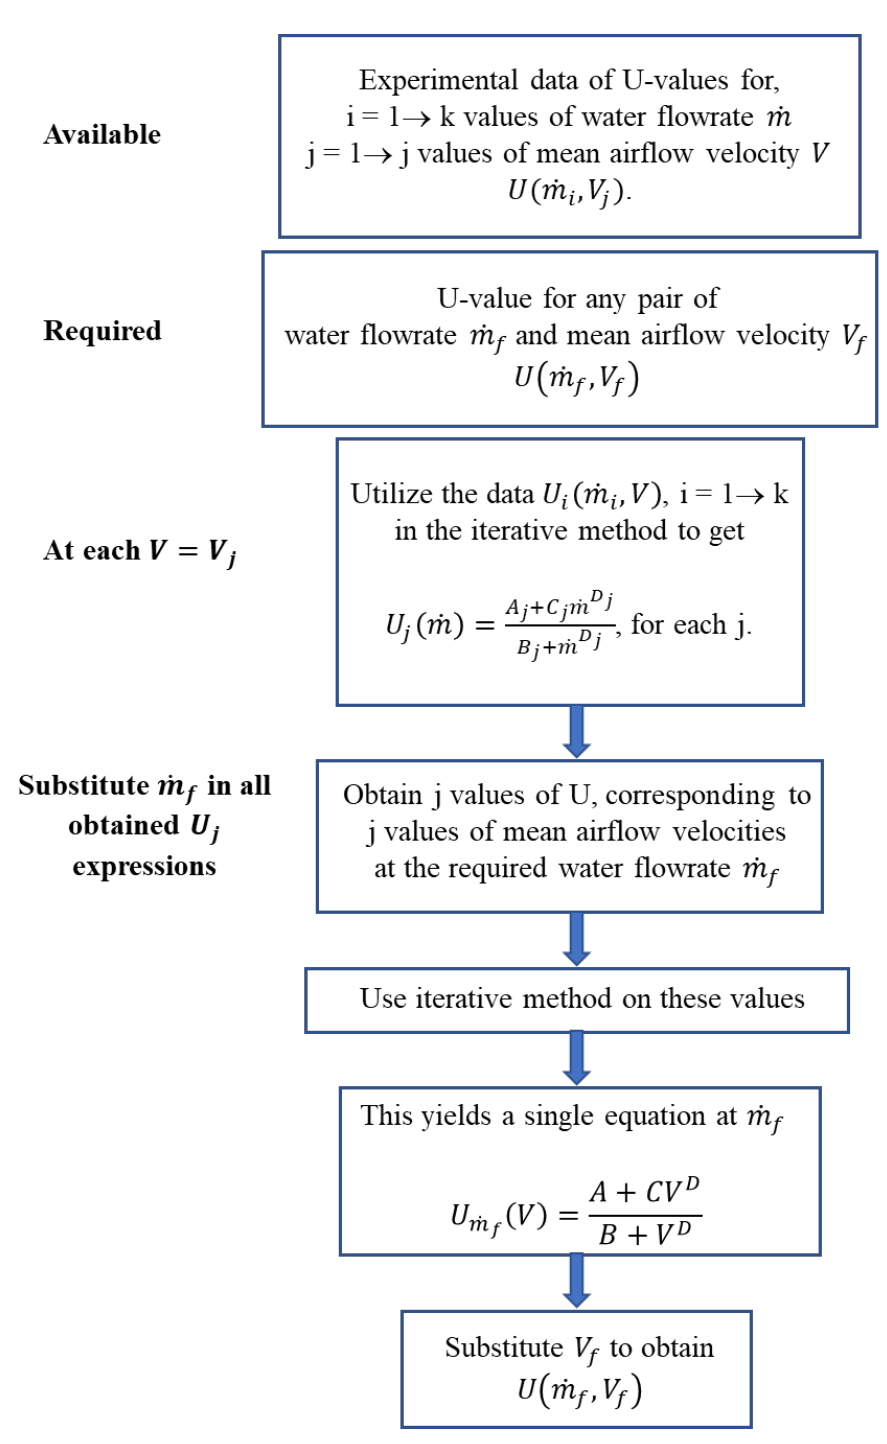
Figure 6. Flow chart of the U-value estimation with the developed code.